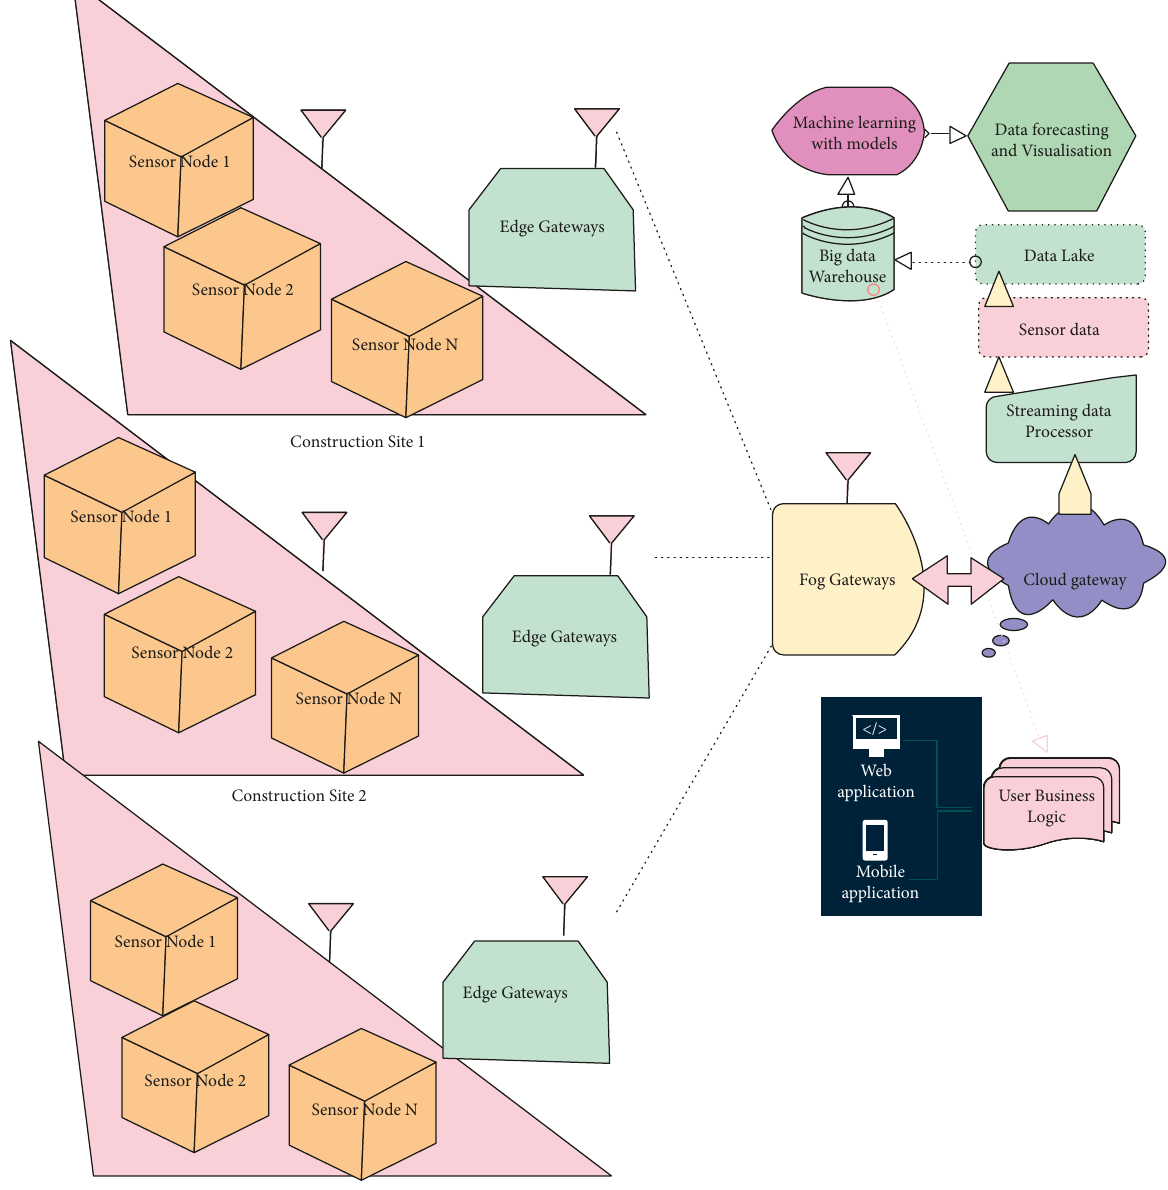
Figure 14: Edge and fog computing framework for the